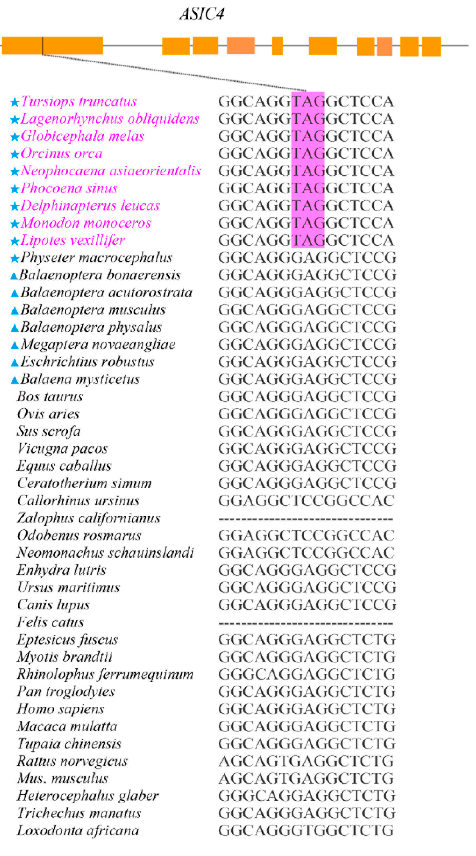
Figure 1. Pseudogenizations were detected in the ASIC4 of almost all the toothed whales. A schematic diagram of the gene structure of ASIC4 in the bottlenose dolphin is shown ( on the top ). Orange rectangles indicate exons and the black vertical bar indicates the location of premature stop codons. All 10 toothed whales in this study, except for sperm whales, had premature stop codons in the first exon of ASIC4 . Blue stars represent toothed whale species; blue triangles represent baleen whale species. Purplish red font represents species with detected pseudogenes, and purplish red boxes are stop codons.